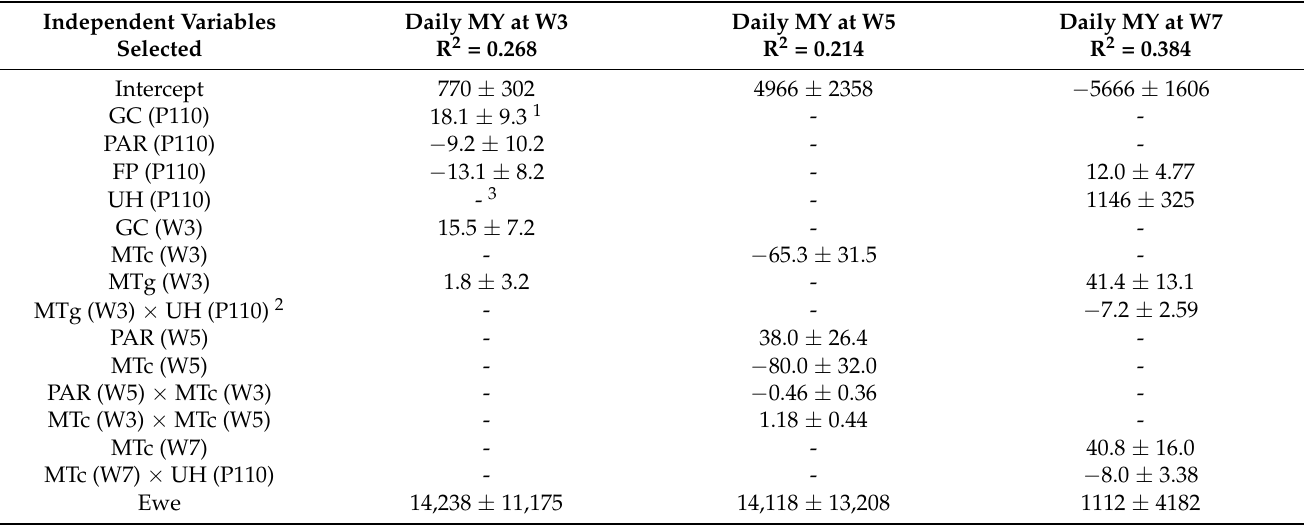
Table 6. Multiple regression coefficients ( ± s.e.m.) of ultrasound (GC, PAR, FP, MTc and MTg) and morphological measurements (UH) in pregnancy (P110), week 3 (W3), 5 (W5) and 7 (W7) of lactation on daily milk yield (MY) in week 3, 5 and 7 of lactation per udder halves